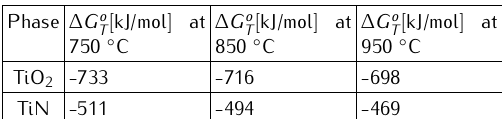
Table 4. Calculatedfreeenergiesofformation( at temperature range 750 - 950 ◦